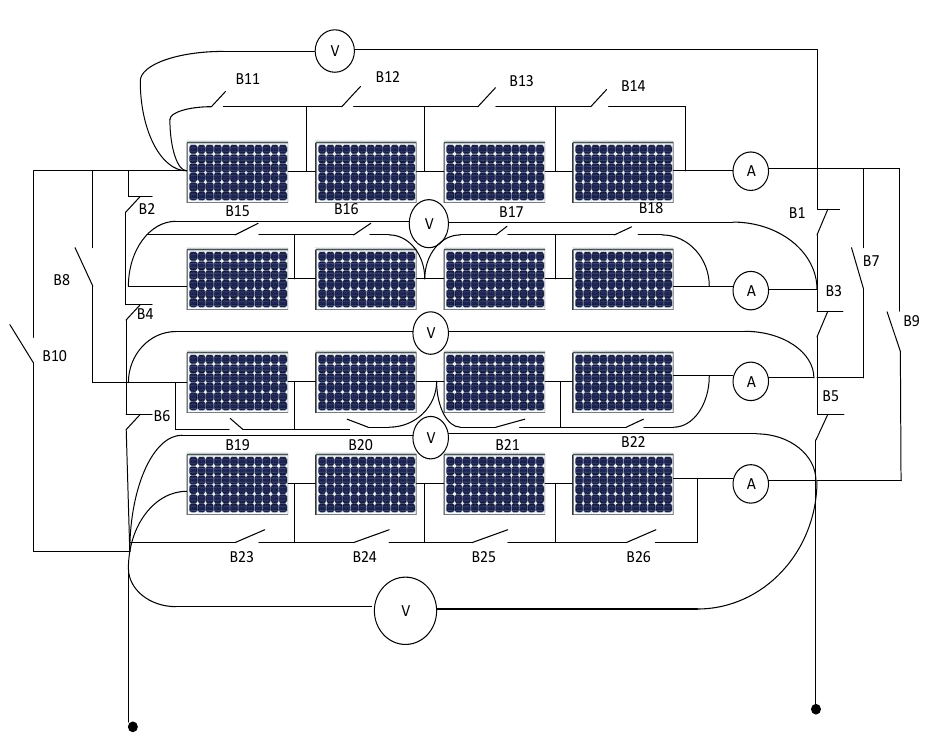
Figure 1. Photovoltaic array arrangement.